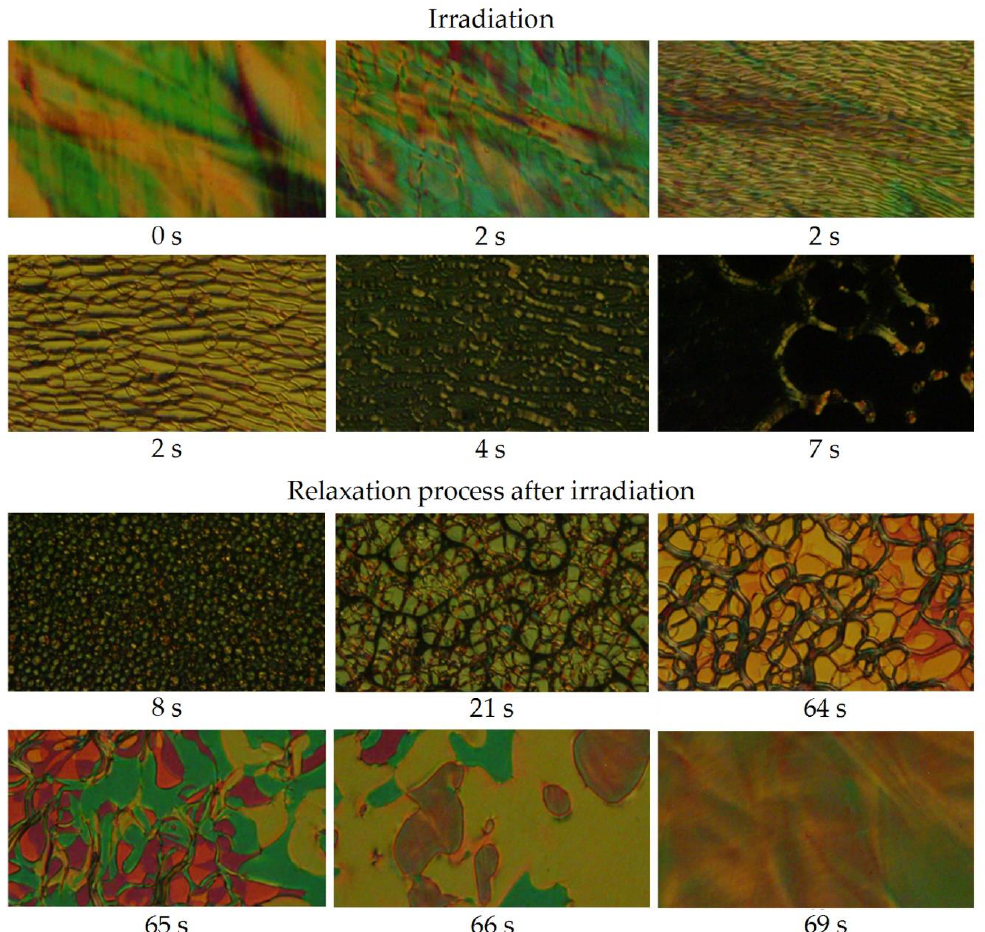
Figure 5. Photos of structural changes in SmA* mesophase of the material IIa in a planar ITO-cell at 95 °C observed in POM: before irradiation (0 s); during UV-light (365 nm) irradiation in time (2–7 s) and after irradiation (relaxation process) in time (8–69 s). Initial fast structural changes of the mesophase are assigned with the same time 2 s. The width of each microphotograph is about 250 μm. The whole transition is documented in a supplementary video file Mov_Fig5.